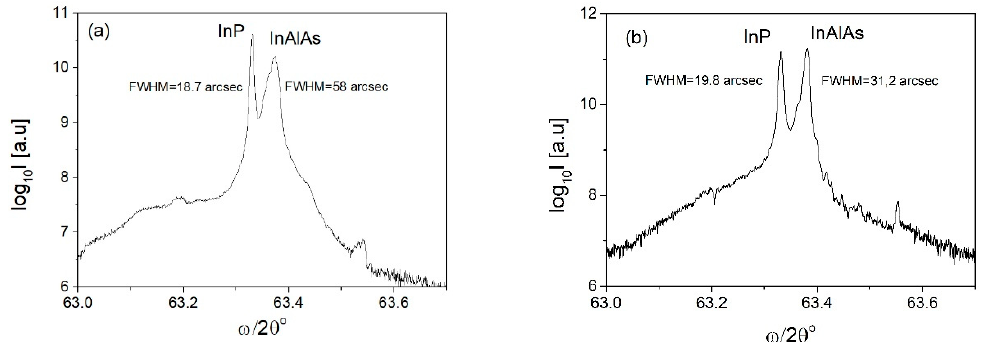
Figure 6. The ω / 2 θ scans of InAlAs / InP test samples for growth temperatures: ( a ) T g = 520 ◦ C and ( b ) Figure 6. The ω /2 θ scans of InAlAs/InP test samples for growth temperatures: ( a ) T g = 520 °C and T = 480 ◦ C. V / III = 17 flux ratio was used in both cases. ( b ) T = 480 °C. V/III = 17 flux ratio was used in both cases.